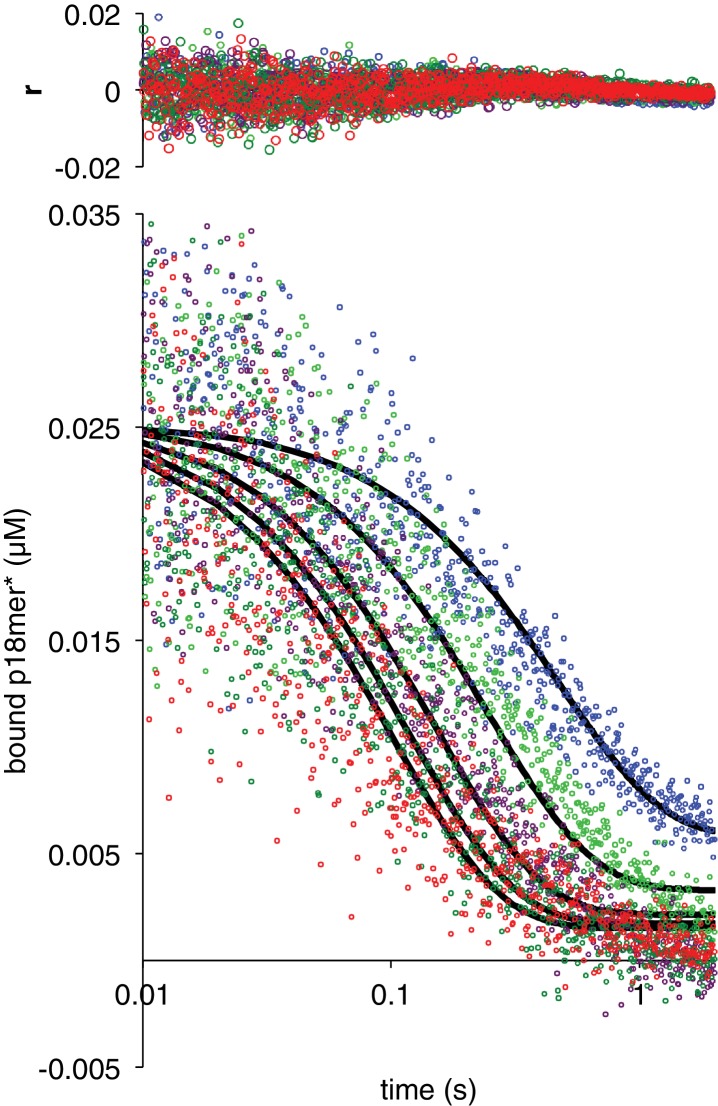
Dissociation of ΔZn2 from p18mer*.Global fits of five representative concentrations of competitor DNA are shown: 0.15 µM (blue), 0.4 µM (light green), 1 µM (violet), 2 µM (dark green), and 4 µM (red) to the kinetic mechanism in Scheme 3. Residuals for the five concentrations are shown overlaid in the corresponding colors above each plot.10.7554/eLife.37818.035Figure 4—figure supplement 4—source data 1.Dissociation of ΔZn2 from p18mer*.